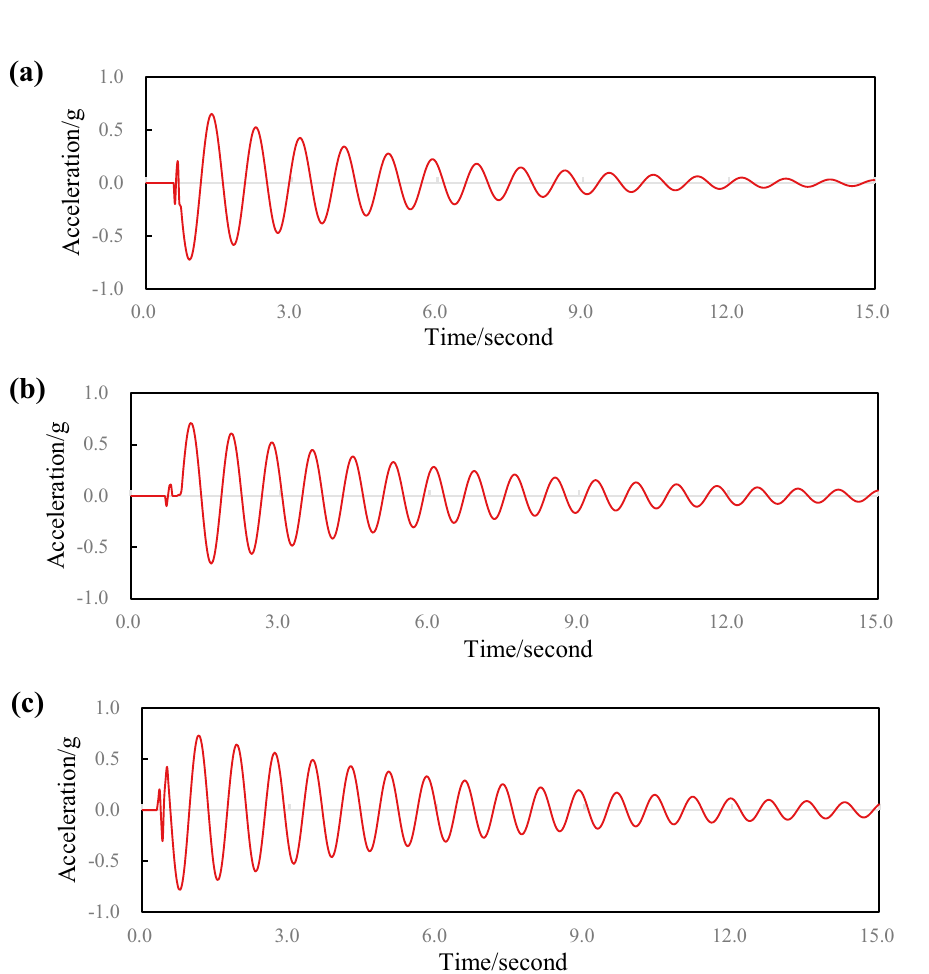
Figure 10. Vibration attenuation curve of composite leaf spring with different volume contents; ( a ) specimen 4 test data; ( b ) specimen 1 test data; ( c ) specimen 5 test